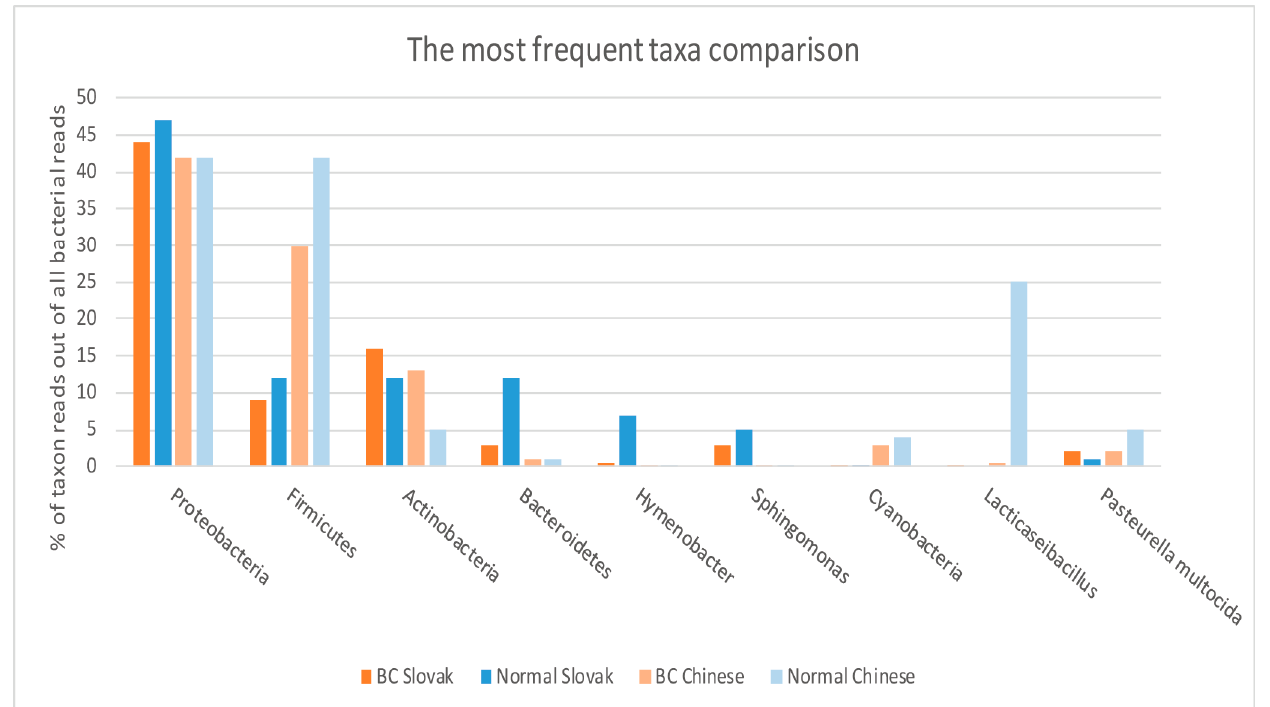
Figure 2. Comparison of abundance (in % of all bacterial reads calculated by Krona evaluation of multiple Kraken2 ouputs) of the most frequent taxa between all basic groups: breast tumour tissue of Slovak patients with breast cancer, normal breast tissue of Slovak donors, breast tumour tissue of Chinese patients with breast cancer (SRA study PRJNA553096), normal breast tissue of Chinese donors (SRA study PRJNA553096), Numerical values for every sample individualy are listed in the Supplementary Table S1.